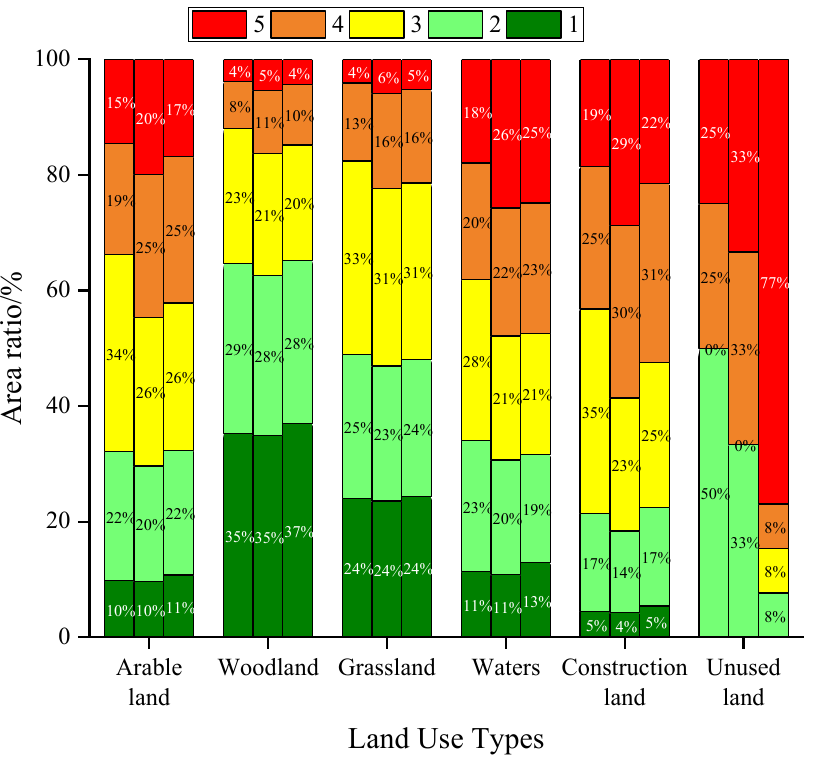
Figure 6. Distribution of ecological risks by land-use types. Note: 1, 2, 3, 4, and 5 represent low risk, low–medium risk, medium risk, medium–high risk, and high risk, respectively.